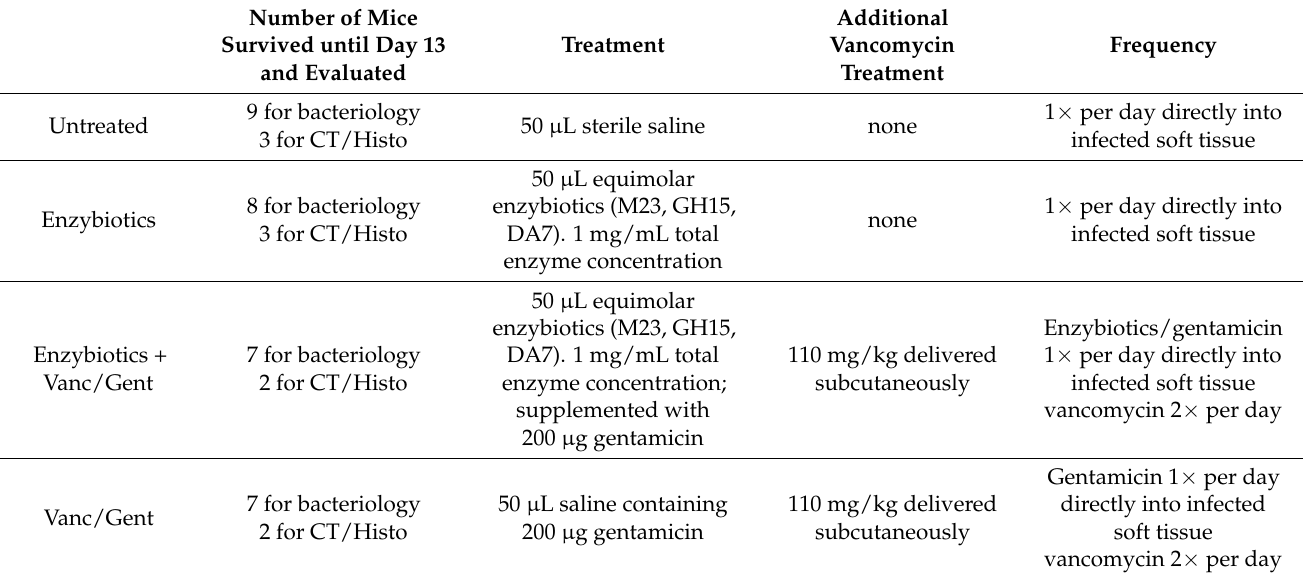
Table 1. Treatment regimens for 5 days following revision